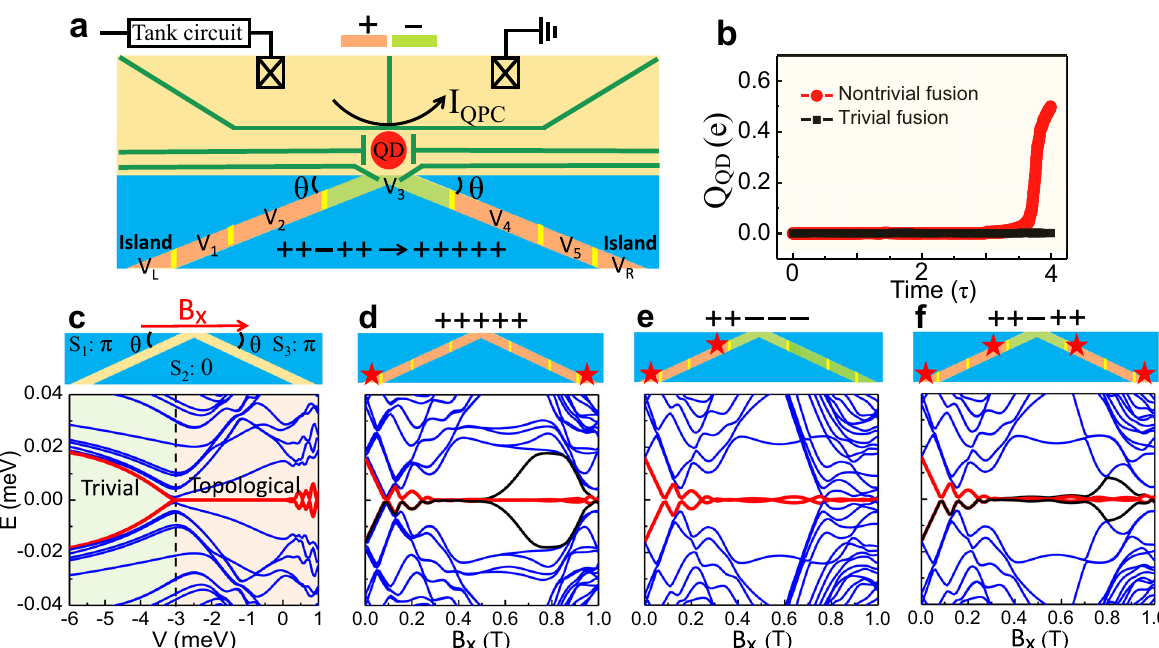
Fig. 6 Mini-gate controlled topological transition and MBS fusion in the VJ. a Schematic of a setup with fi ve mini gates and two quantum islands, “ L ” and “ R ” , for the preparation of the initial states, with voltages V V L , and V R . A quantum dot (QD) together with a quantum point contact (QPC) is coupled to 1 − 5 , the apex of the VJ to detect the fusion outcome. b Calculated charge average of the QD, Q QD , induced from the process of the trivial and nontrivial fusion, where τ is the mini-gates switching time with 1/ τ ~ GHz. c Schematic (top) and energy spectra (bottom) for a VJ with superconducting phases ( π , 0, π ) at B x = 0.7 T as a function of the gate voltage V , tuned by the top gate (not shown), which covers the whole N region. The black dashed line indicates the V c between the trivial (green) and topological (orange) regions. d – f Schematic (top) of a VJ with MBS (stars) for the + + + + + , + + − − − , and + + − + + con fi gurations at B x = 0.7 T and the corresponding energy spectra (bottom). Red and black lines: evolution of fi nite-energy states into MBS inside the topological gap. The geometric parameters are L = 3.6 μ m, W = 0.6 μ m, W N = 0.1 μ m, and θ = 0.1 π . Other parameters are speci fi ed in the main text.